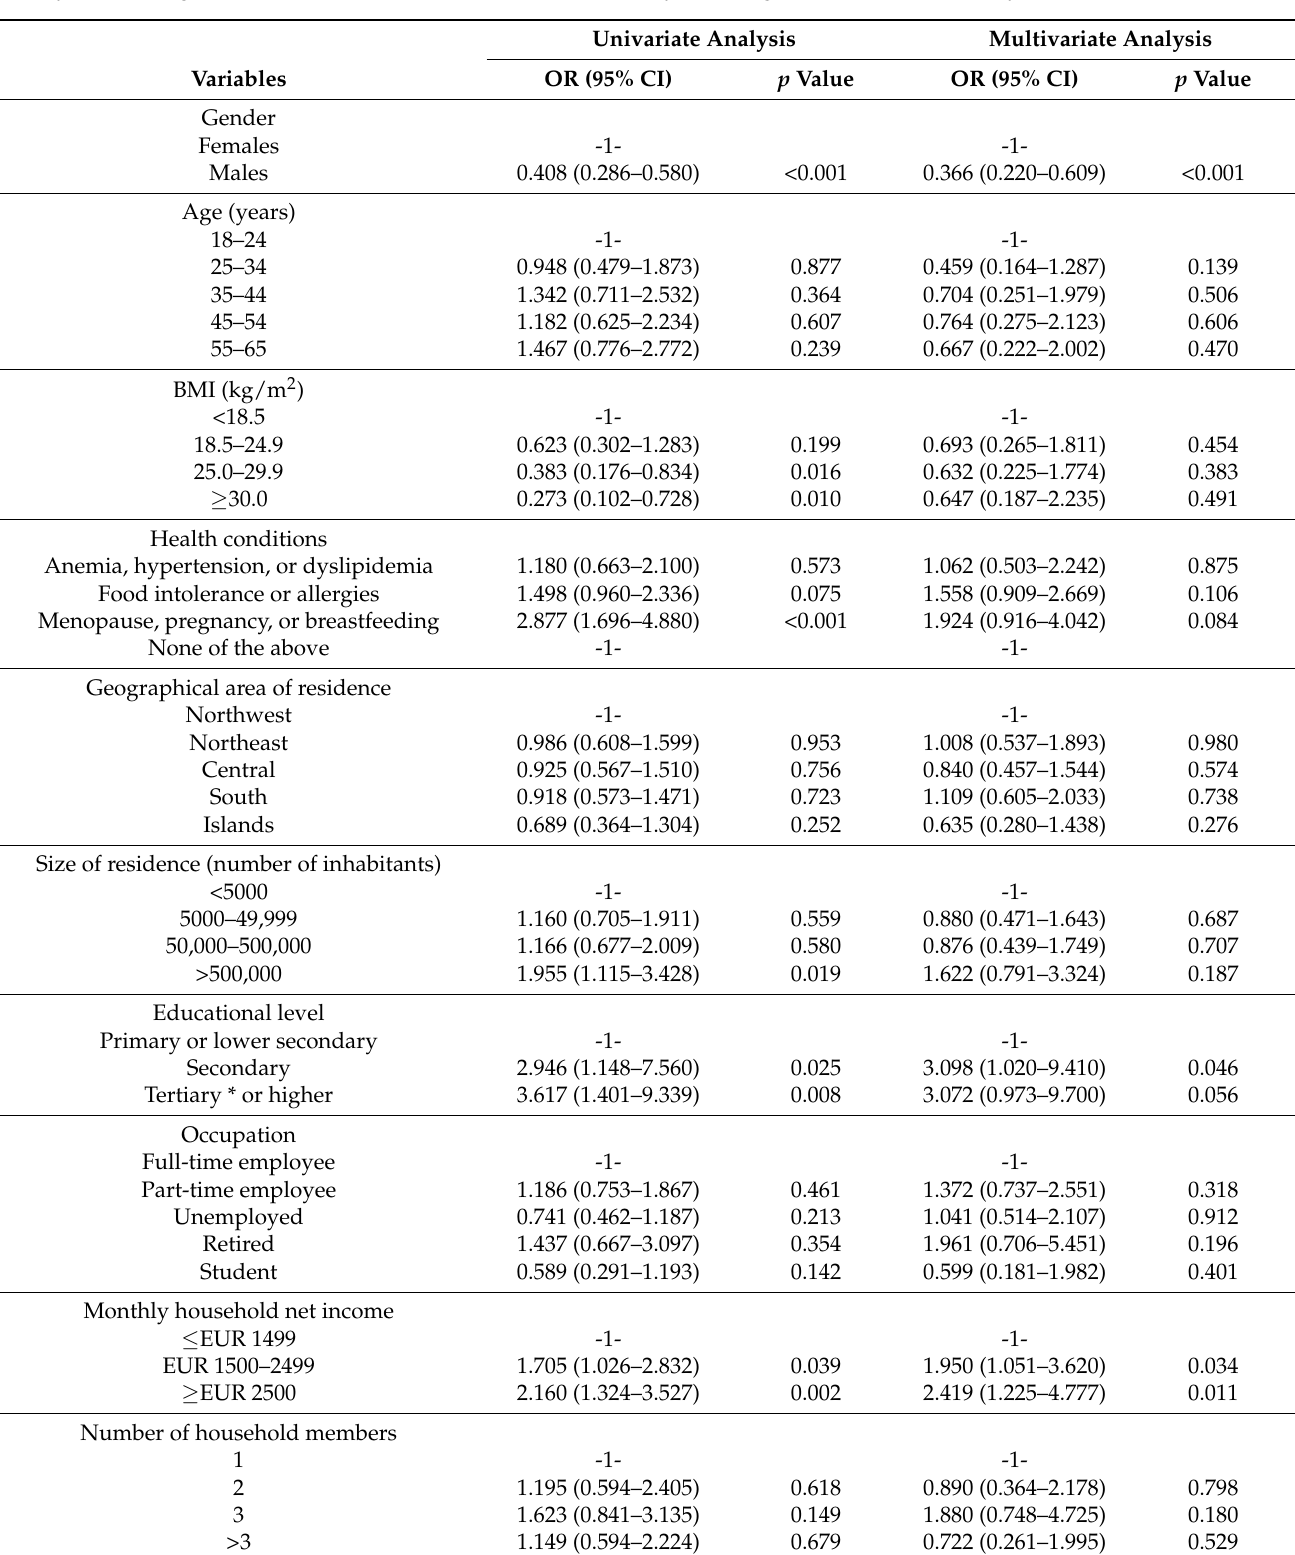
Table 3. Logistic regression analysis for being in the third tertile of distribution of the adherence score to the MD (6-9 points) by considering all the assessed variables alone (univariate analysis) or together (multivariate